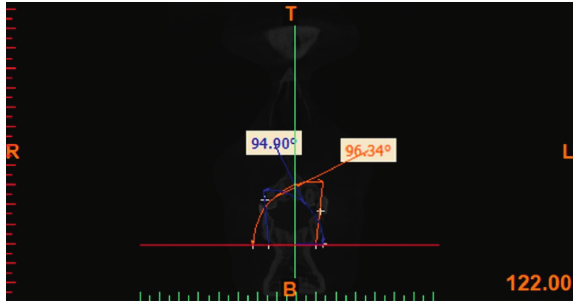
Figure 5: Measuring the inclination of mandibular